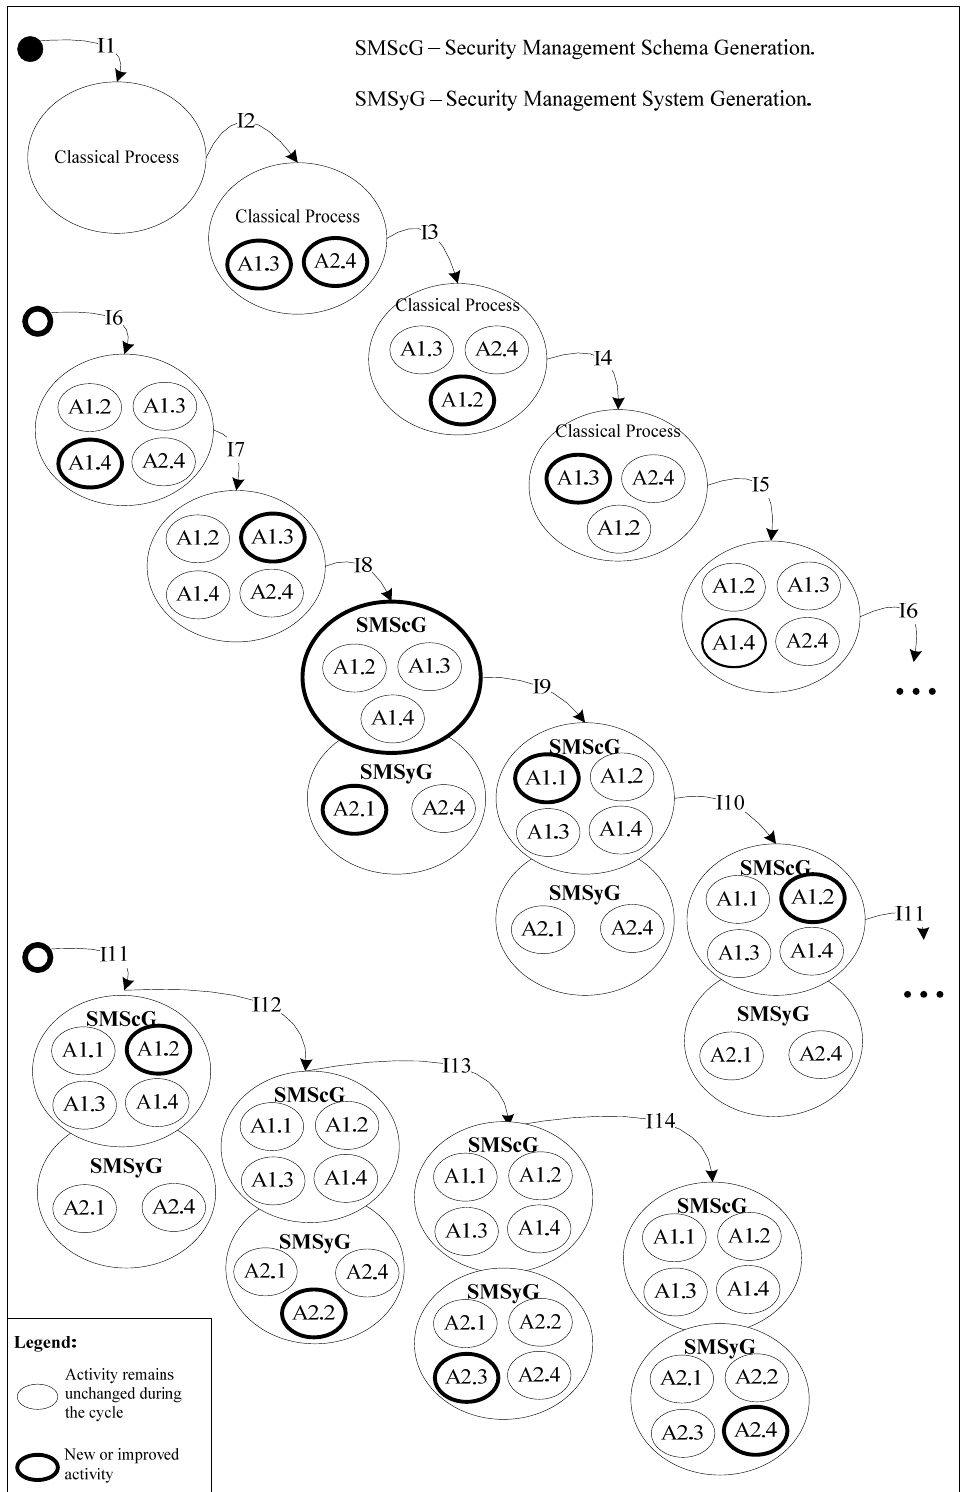
Figure 3. The use of AR to obtain the SMScG and SMSyG processes.